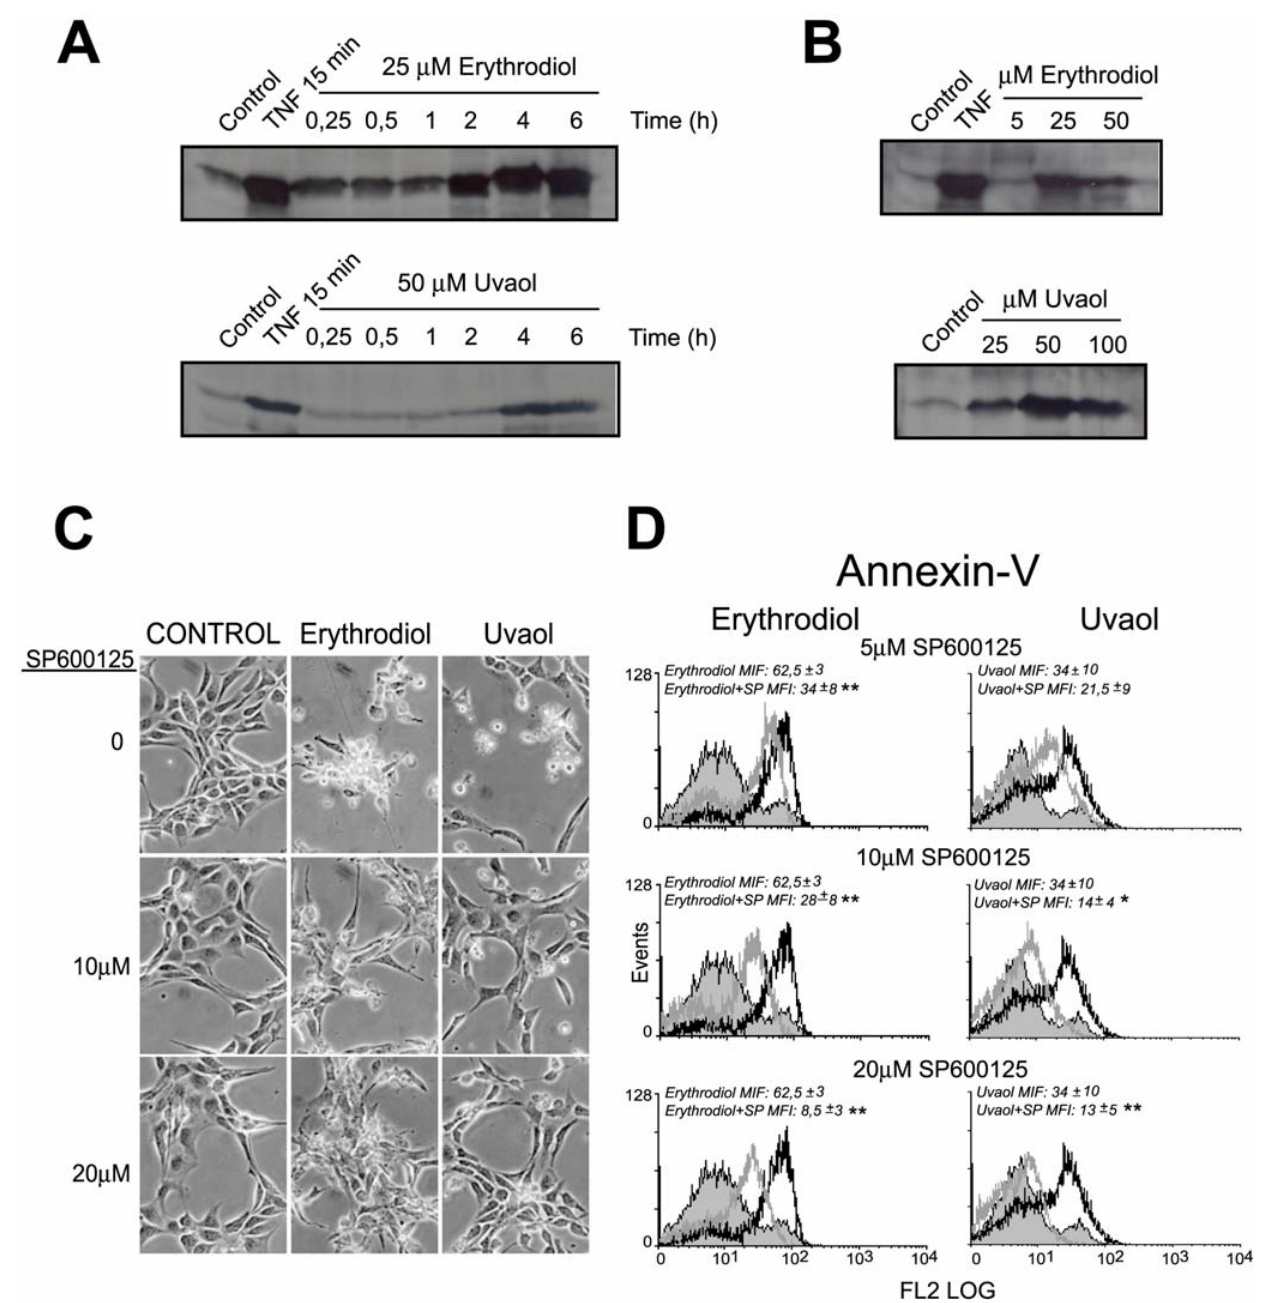
Figure 5. Effect of triterpenic diols in JNK activation. Cells were stimulated with 25 m M erythrodiol or 50 m M uvaol at the indicated times (A), or with different doses of erythrodiol or uvaol for 4 h (B), and assayed for an in vitro JNK-kinase assay as described in Materials and Methods. Exposure to 200 U/ml of TNF for 15 min was used as positive control. Results are representative of four separate experiments. Cells were exposed to different doses of SP600125 in the presence of 25 m M erythrodiol or 50 m M uvaol for 18 h. Then, the cells were analyzed by phase-contrast microscopy using a Nikon Eclipse TS100 microscope ( 6 40; C) or labeled with annexin V–PE and analyzed by flow cytometry (D). In the histograms, cells obtained after triterpene treatment in the absence of the inhibitor ( open black curves) are compared with cells treated in the presence of the inhibitor ( open gray curves). Gray solid curves, resting control cells. *p , 0.05, **p , 0.01, vs triterpenes treated cells in the absence of the inhibitor.